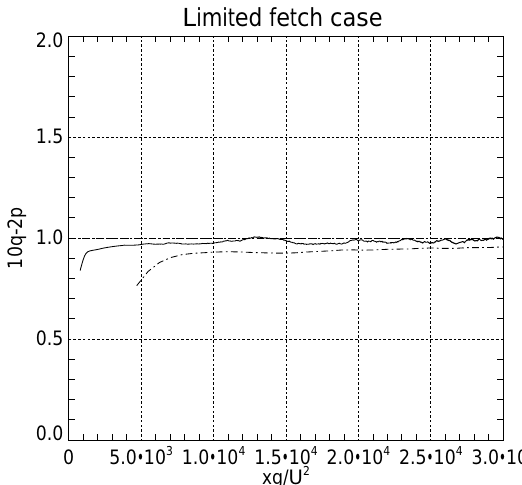
Figure 18. Typical, angle averaged, wind input function density R γ(ω,θ)ε(ω,θ) d θ (dotted line) and angle averaged (cid:104) S (cid:105) = 1 in 2 π R ε(ω,θ) d θ (solid line) as the functions of the spectrum (cid:104) ε (cid:105) = 1 2 π frequency f = ω for the wind speed U = 10ms − 1 limited fetch 2 π